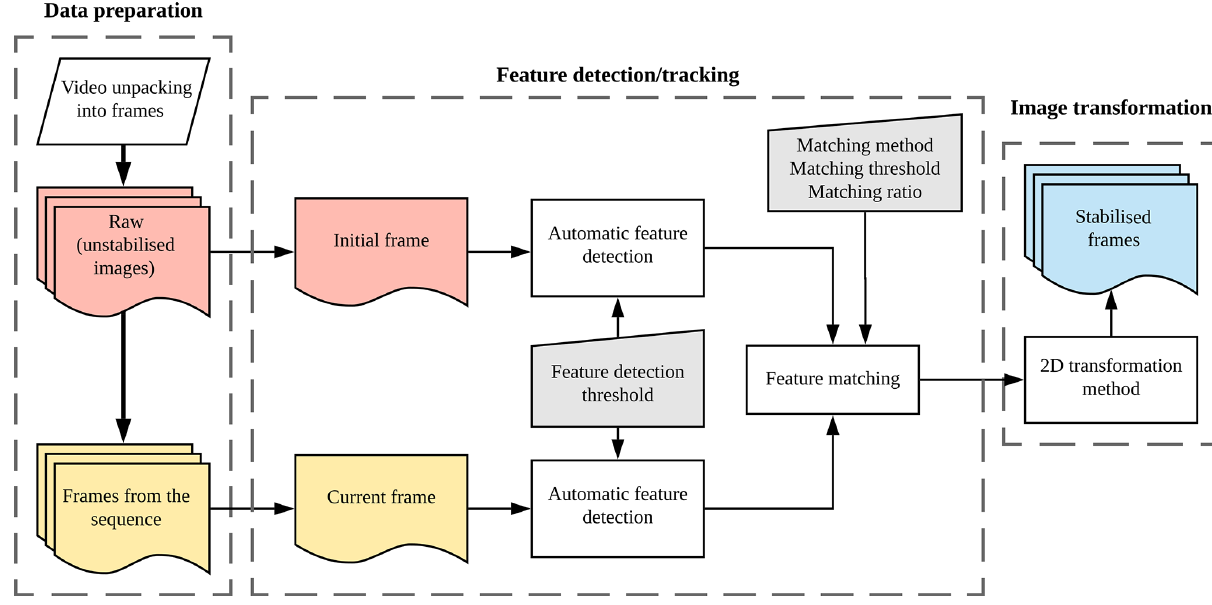
Figure 2. General outline of the automatic feature selection/tracking approach.